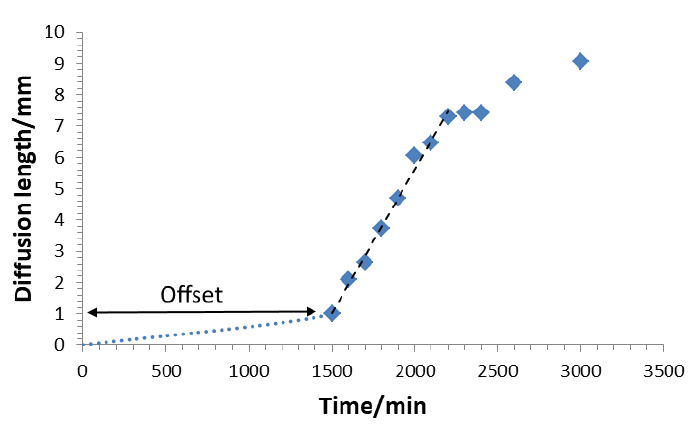
Table 1. Molecule diffusivities in Sylgard-184 [27].